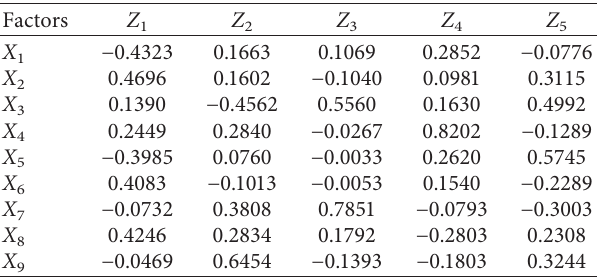
Table 4: Principal component coefficient matrix. Factors